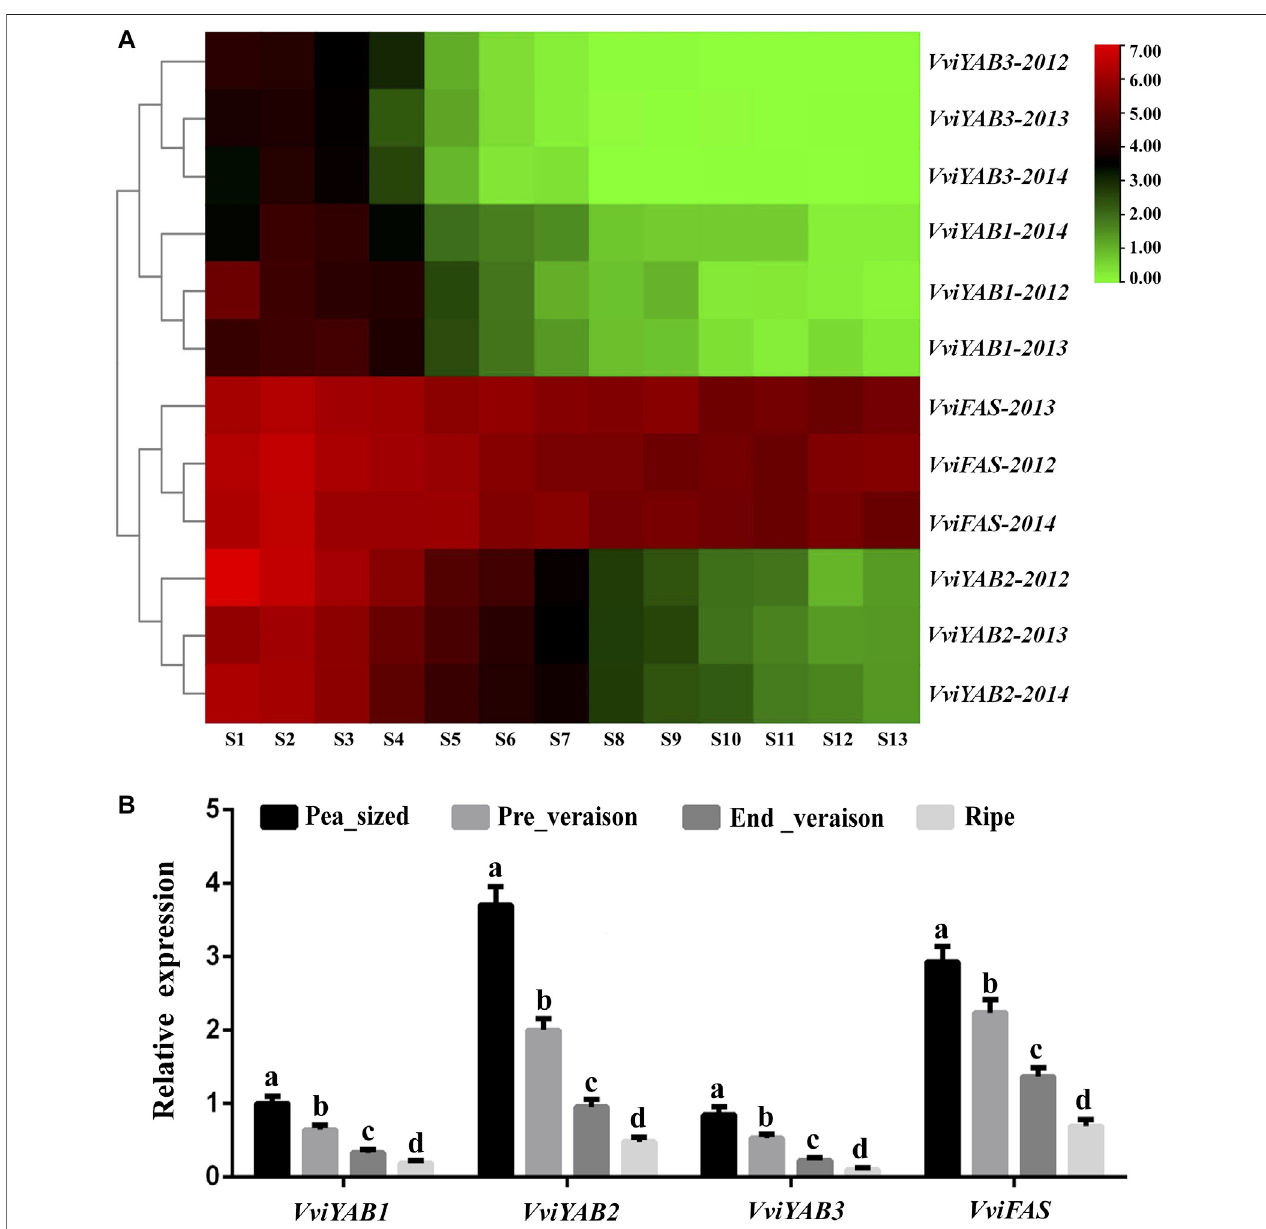
FIGURE 5 | Expression pro fi le of four VviYAB genes during developmental and ripening berry in grapevine. (A) Expression of VviYAB genes in the V. vinifera cv “ Cabernet Sauvignon ” atlas. Berries were collected at 10-day intervals in 2012 and weekly in 2013 and 2014, beginning at fruit set and continuing until harvest (24.5 ° Brix). S represents stage. Expression data were normalized based on the mean expression value of each gene from fruit set to full maturity. The mean expression valueswereagainnormalizedusinglogarithmwiththebaseof2usingtheHemlsoftware.Genenamesaredisplayedtotherightofeachrow. (B) qPCRvalidationof VviYABs expression in four berry development stages. Transcripts were normalized to the expression of the actin gene. The data are shown as means ± SD of three replicates.